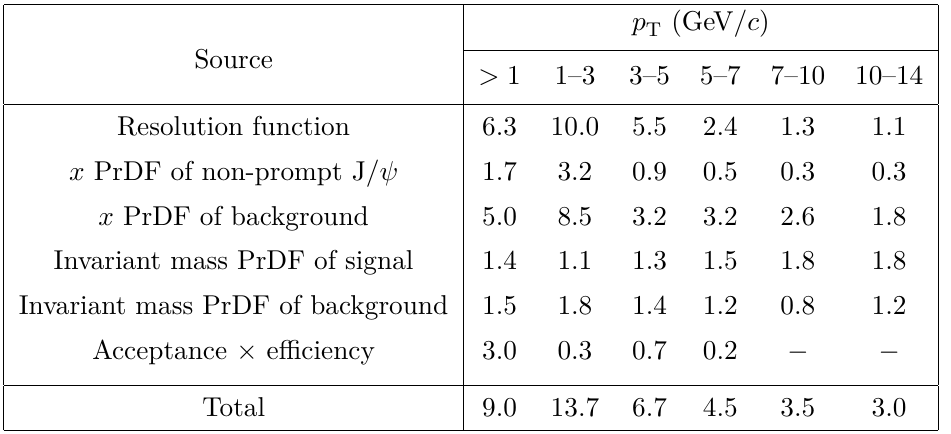
Table 2 . List of the systematic uncertainties (in percent) for the fraction of J /ψ from b-hadron decays in the different analysed p intervals. The symbol “ − ” denotes a negligible contribution. T √ The value of f in pp collision at s = 5 . 02 TeV, indicated as f pp b